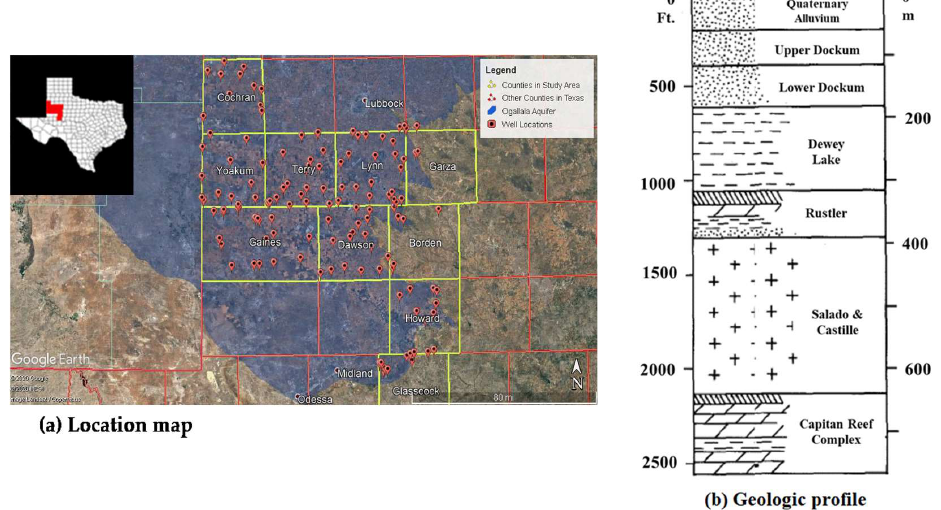
Figure 1. ( a ) Location of groundwater wells and ( b ) the geologic profile in the study area including the underlying Ogallala Aquifer (cited from Shannon et al. [2] and Nelson et al. [11]).